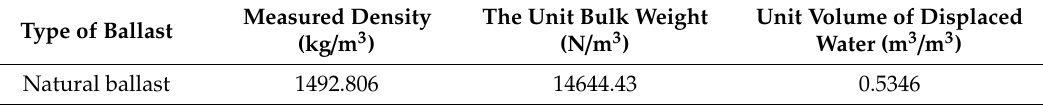
Table 6. Physical properties of ballast tested in lab.